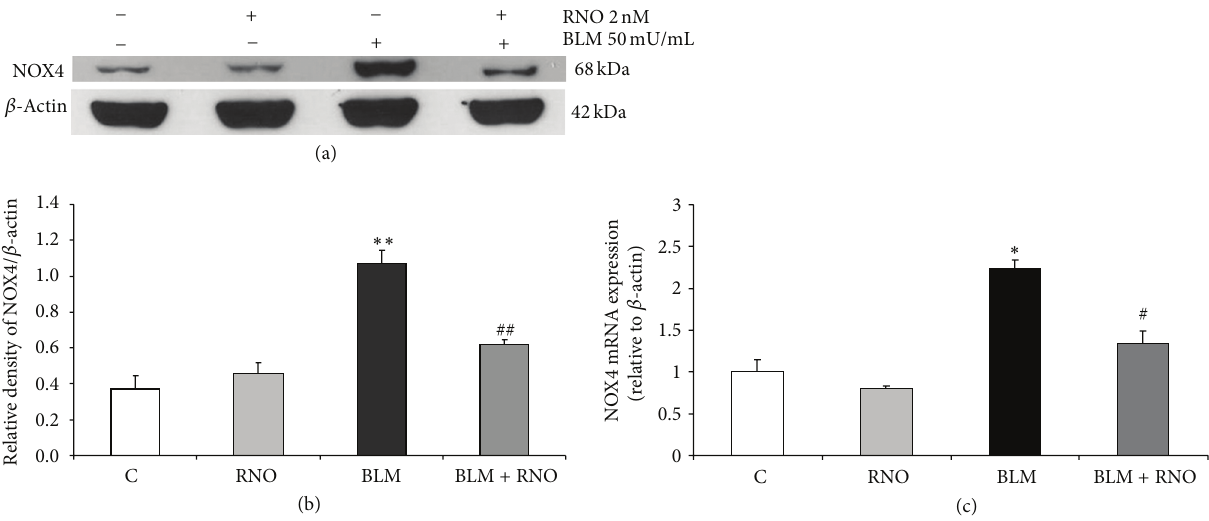
Figure 5: Effect of BLM and RNO on NOX4 expression in HLF. (a) Cells were preincubated or not with RNO (2nM) and then treated for 24 h with BLM (50mU/mL). Protein expression of NOX4 was analyzed by Western blotting. (b) Quantification of proteins was expressed as a ratio to 𝛽 -actin. Data are mean ± SD of 3 experiments. ∗∗ 𝑃 < 0.01 versus control (C); ## 𝑃 < 0.01 versus BLM. (c) NOX4 gene expression in HLF was evaluated by real-time PCR. The isolated mRNA samples were analyzed using the specific primers and compared with 𝛽 -actin (housekeeping gene) levels. Data are mean ± SD of 3 experiments. ∗ 𝑃 < 0.05 versus control (C); # 𝑃 < 0.05 versus BLM.